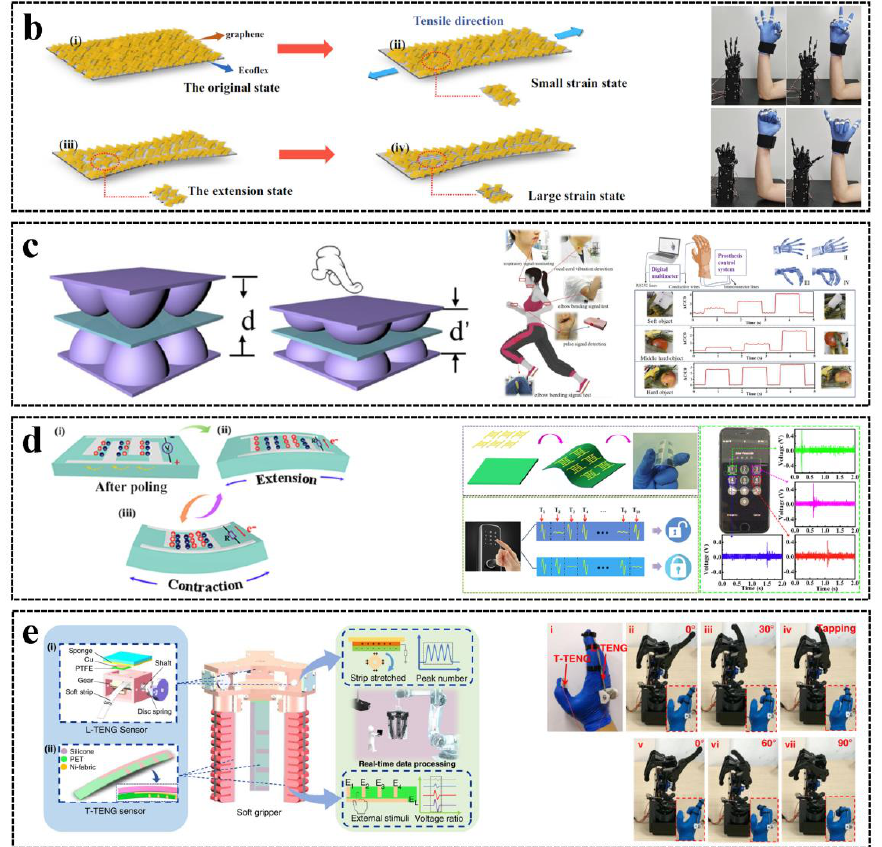
Figure 1. Tactile and force sensors for HMI: ( a ) A resistive pressure sensor for virtual reality. Reproduced with permission [28], Copyright 2019, Elsevier Ltd. ( b ) A resistive strain sensor for robot control. Reproduced with permission [37], Copyright 2022, Springer Nature. ( c ) A capacitive pressure sensor for physiological signal and robot grabbing monitoring. Reproduced with permission [50], Copyright 2020, Elsevier Ltd. ( d ) A piezoelectric pressure sensor for self − powered HMI. Reproduced with permission [60], Copyright 2022, Elsevier Ltd. ( e ) Triboelectric sensors for robot control. (i ) and (ii) are the structures of the L−TENG and T−TENG sensors respectively. Reproduced with permission [66], Copyright 2020, Springer Nature.